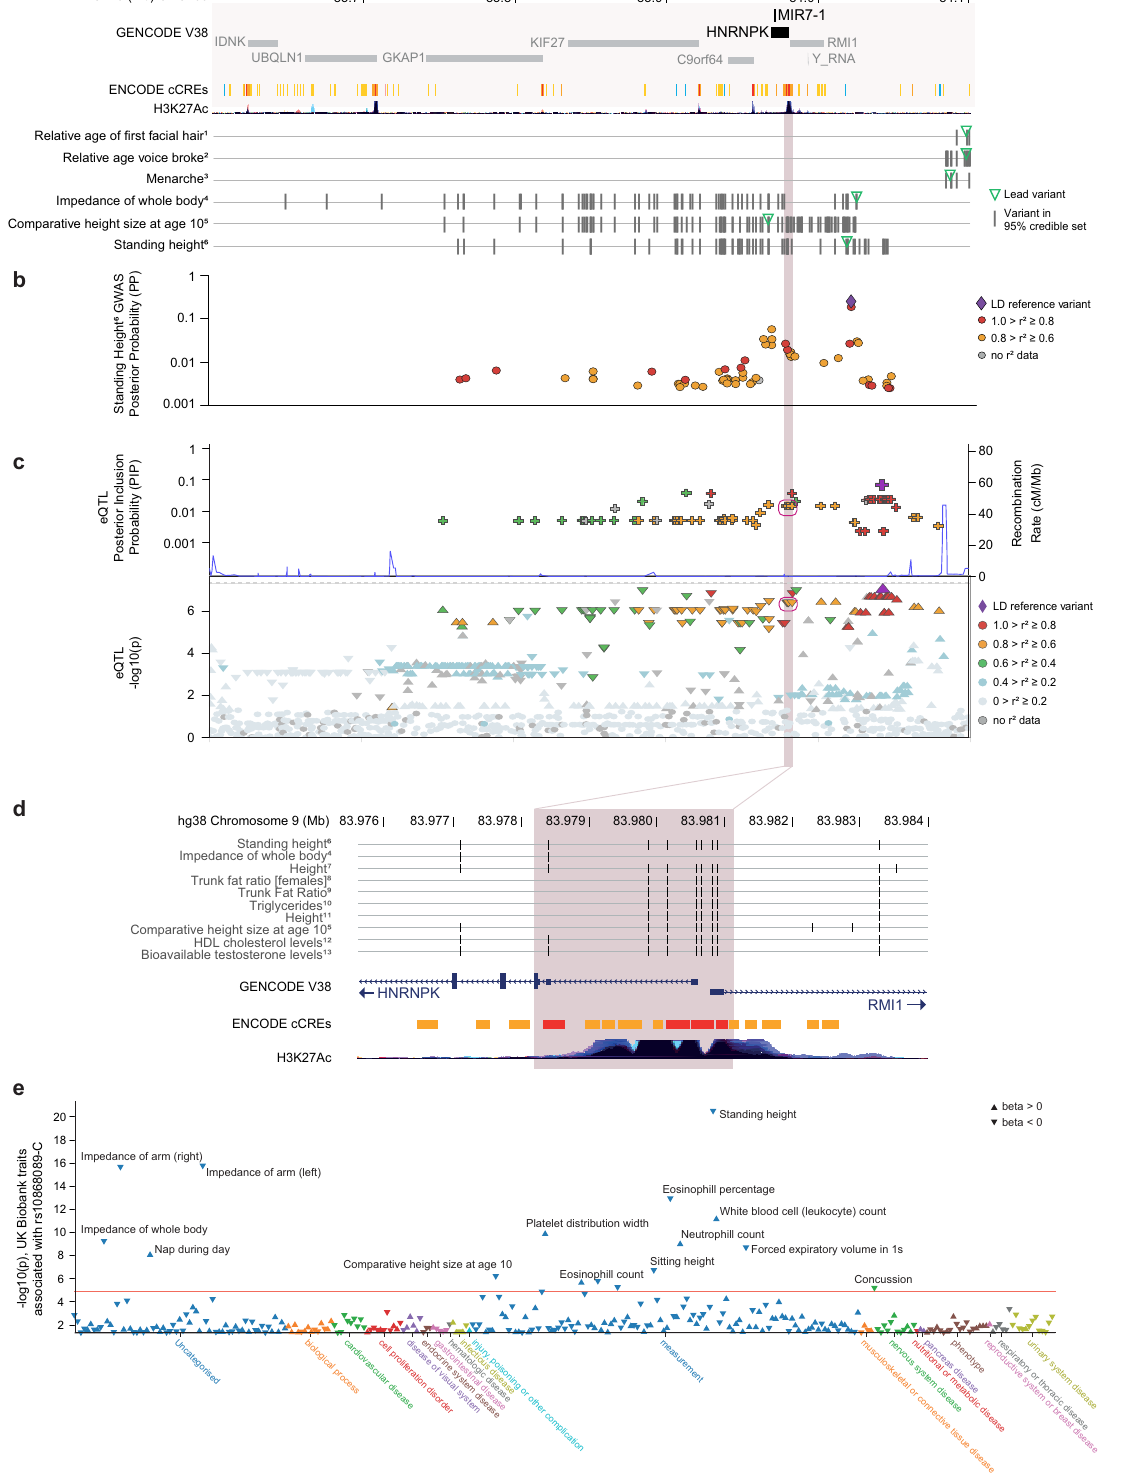
UBC-cre/ERT2;miR-7 fl / fl mice compared to Sim1-cre;miR-7 fl / fl mice. The SON is comprised of magnocellular OXT- and AVP-expressing neurons that release these neuropeptides into circulation through axon term- inals in the posterior pituitary. Sim1 is expressed in neurons of both the PVN and SON, as these two populations arise from a common developmental lineage 5,43 . Thus, deletion of mir-7 in the SON of